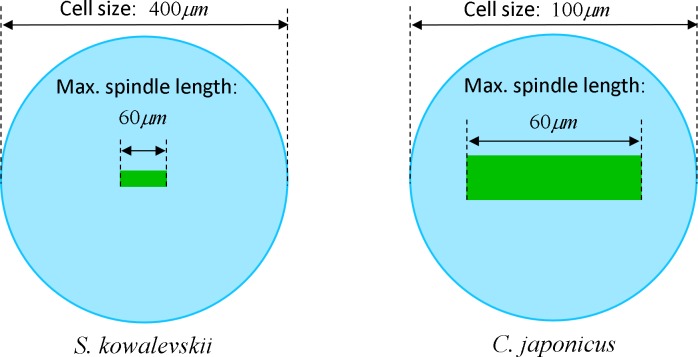
Visualization of the relative geometrical proportion of the maximum spindle length (60 μm) to the size of Sk (400 μm) and Cj (100 μm) cells.Effects of spindle polarization on mechanics of small Cj cells are significantly more pronounced in comparison to four time larger Sk cells.